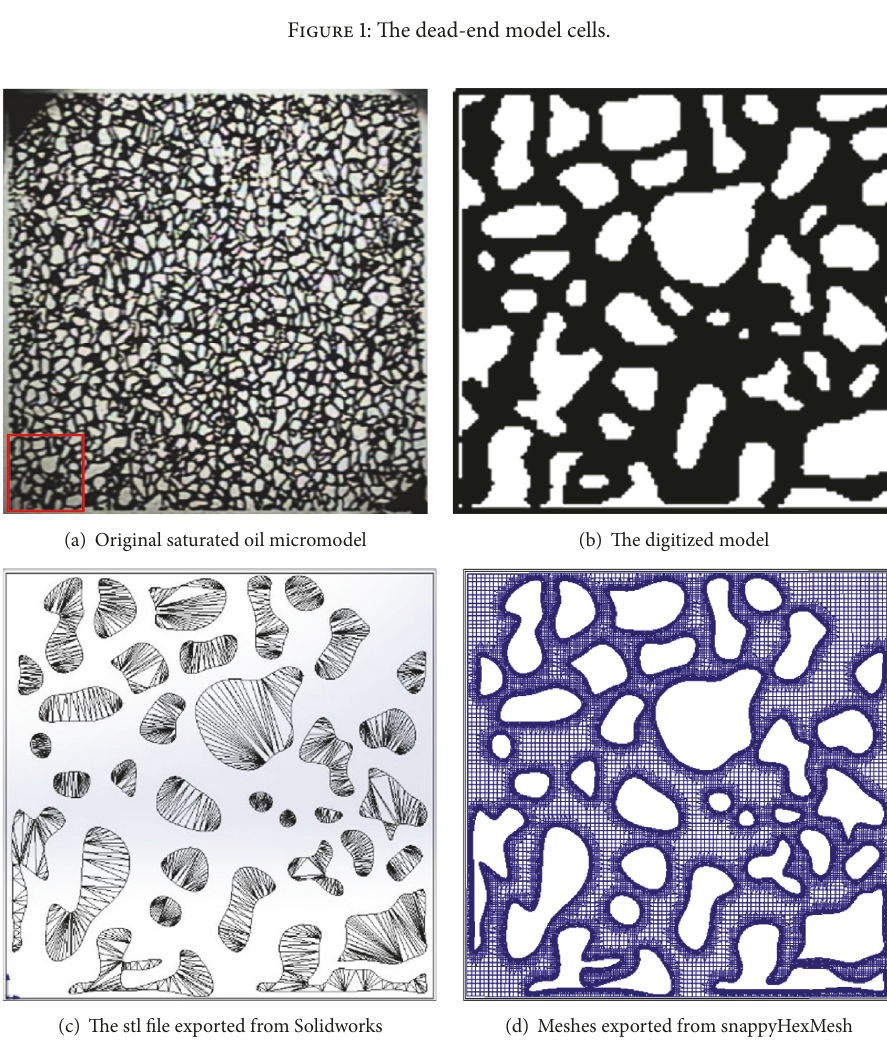
Figure 2: The complex model and the mesh formation